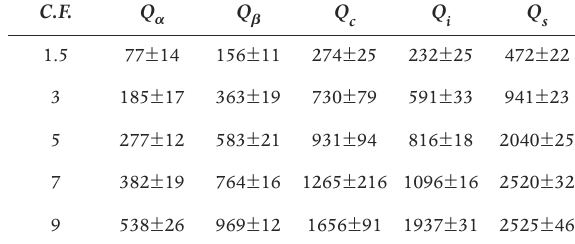
Figure 6. Plot of estimated average Q tion of